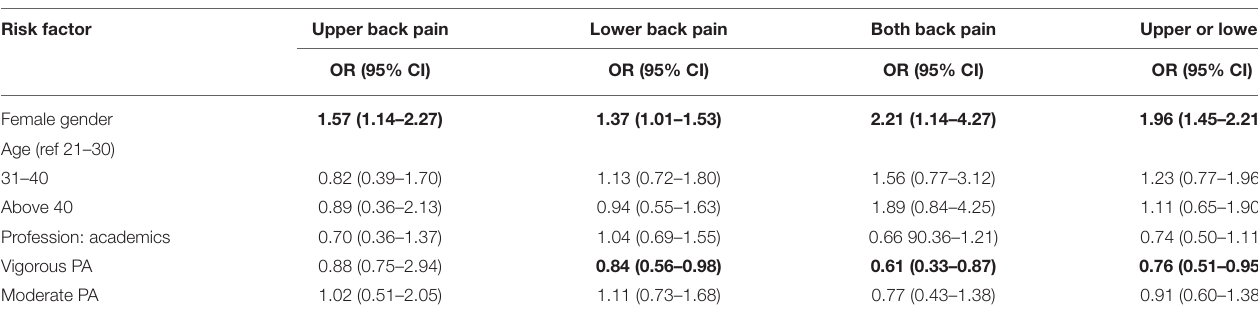
TABLE 2 | Relationship between back pain and levels of physical